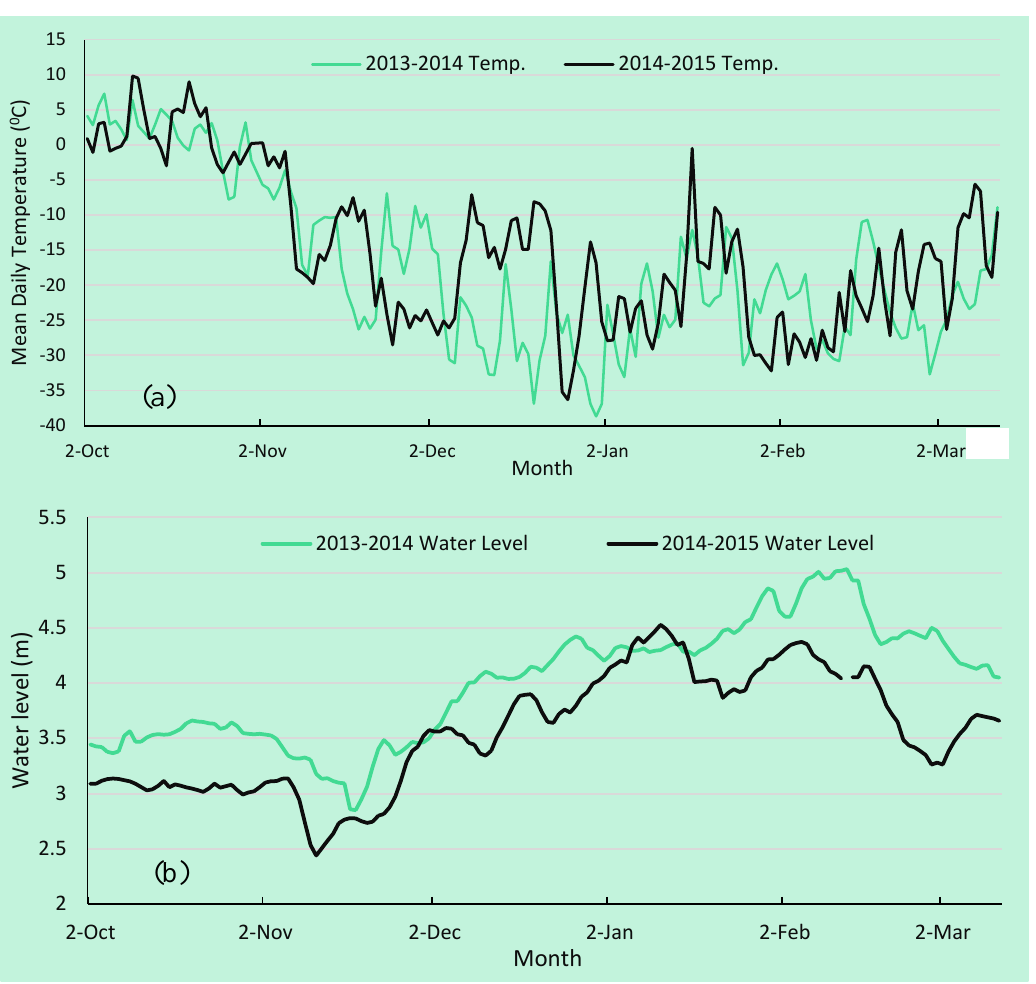
Figure 2. Daily air temperature ( a ) and water level ( b ) during the winters 2013–2014 and 2014–2015 recorded at Fort Smith and Fitzgerald—upstream of Slave River